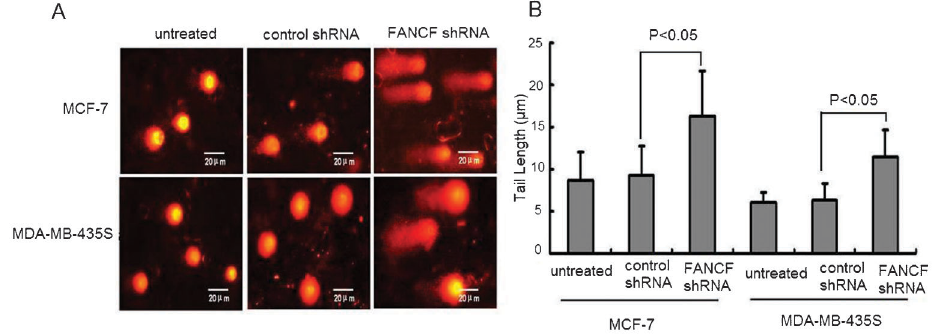
Figure 3. Silencing of FANCF enhanced DNA damage in breast cancer cells. A , Single-cell gel electrophoresis (comet assay) showed detectable comet tails when visualized under a fluorescent microscope, indicative of DNA damage. B , Quantification of DNA fragmentation in the indicated cell lines. Data are reported as means±SD of three independent experiments in triplicate. ANOVA followed by the post hoc test was used for statistical